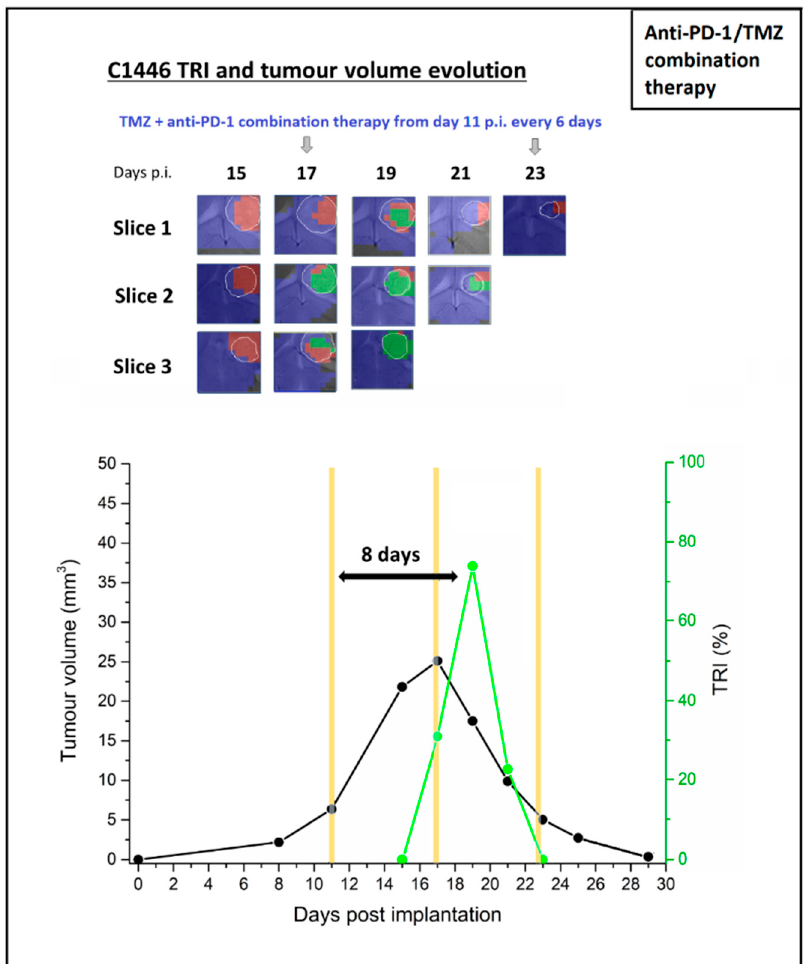
Figure 5. Nosological images and graphical representation of the tumour volume evolution for the tumour region in the case C1446. Tumour volume in mm 3 (black line, left axis) and the percentage of green, responding pixels (tumour responding index (TRI)) obtained taking into account total pixels counting (green line, right axis). In the upper part of every image, chosen time points show the evolution of the nosological images in three rows of colour-coded grids superimposed to the T2w-MRI for each slice. Vertical arrows indicate days of therapy administration. In the bottom graph, yellow columns indicate anti-PD-1 / TMZ combination therapy administration days. TRI cycle duration (therapy administration to next peak maxima) is highlighted in the image. The TRI peak appears 8 days after the first round of PD-1 / TMZ administration.